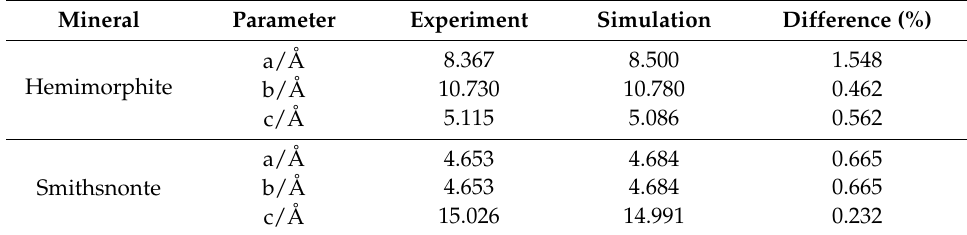
Table 2. Simulation and experimental lattice parameters of hemimorphite and smithsonite crystal. Mineral Parameter Experiment Simulation Difference (%) Hemimorphite